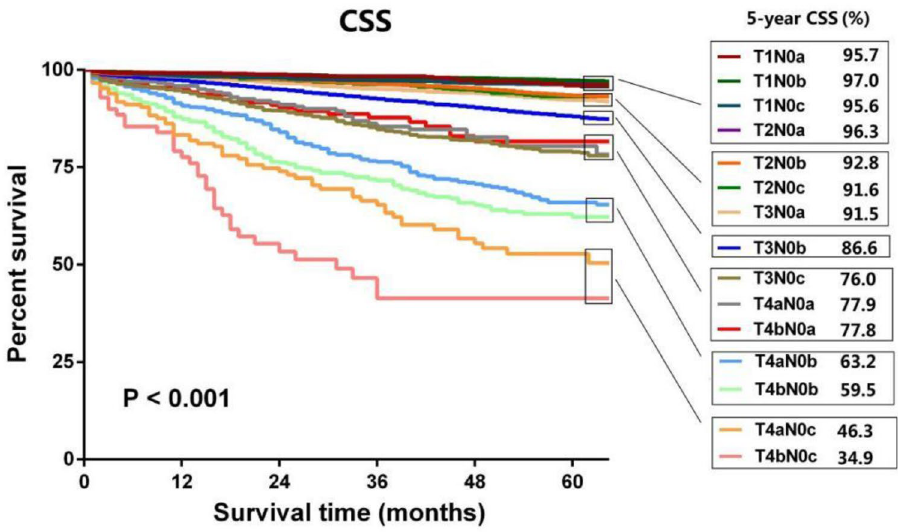
Figure 2. Kaplan–Meier curves for patients in different subgroups in the development cohort.